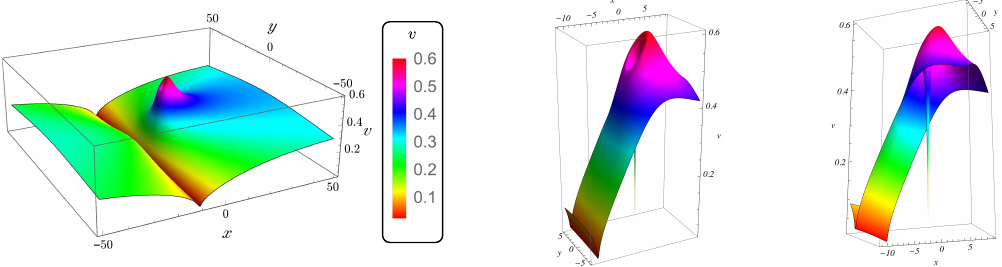
Figure 2. Same as Figure 1 but with anisotropic Newton’s law and with ρ 2 .